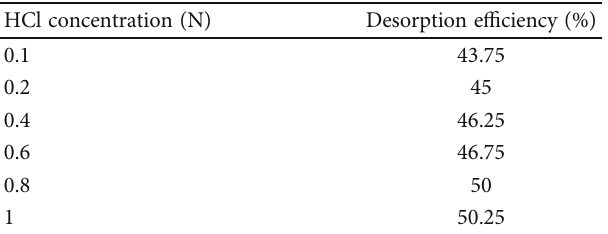
Figure 9: Dendrogram of the cluster analysis for all treated samples based on adsorption conditions. At a similarity level of 51.1, 4 main clusters were observed similar to PCA. Table 3: Desorption e ffi ciencies at various HCl concentrations at the initial concentration of phenol of